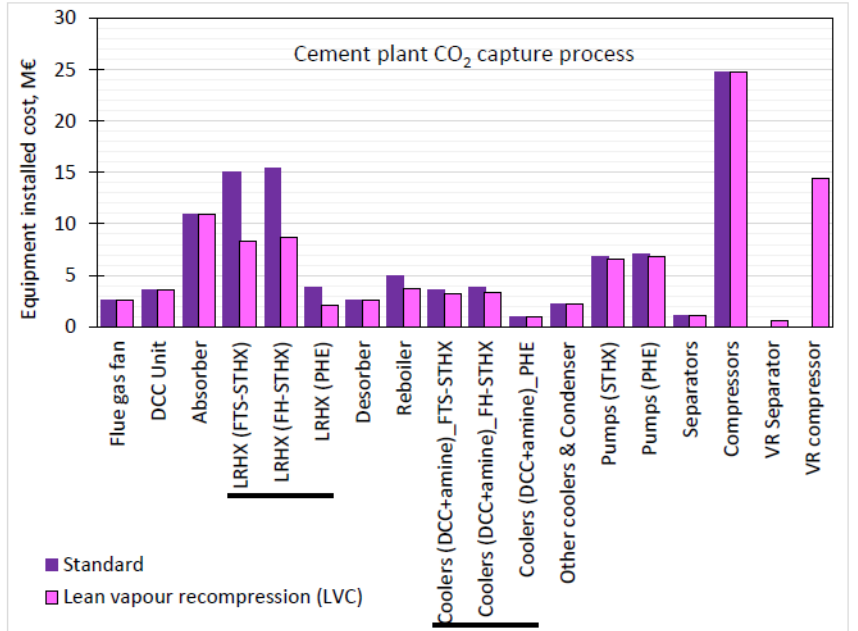
Figure 4. Capital cost distribution of 90% CO 2 standard capture plant and lean vapour compression plant for cement plant’s flue gas.